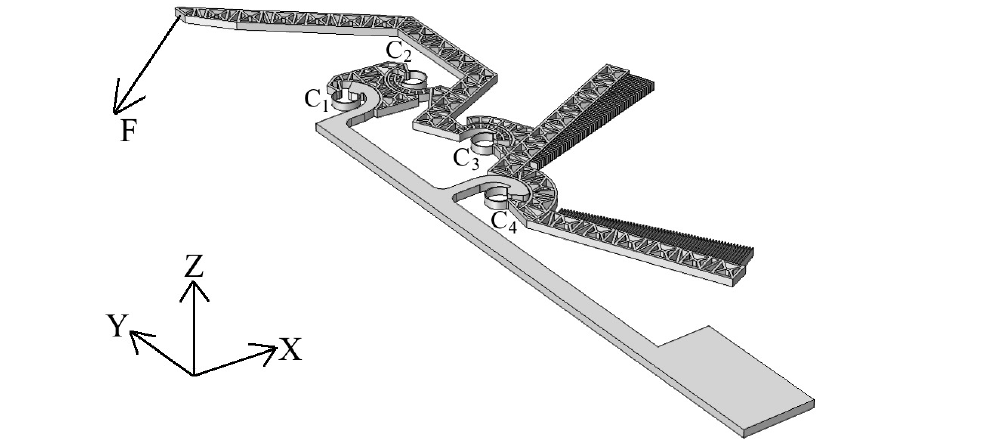
Figure 5. Static load to modify the CSFH contact.